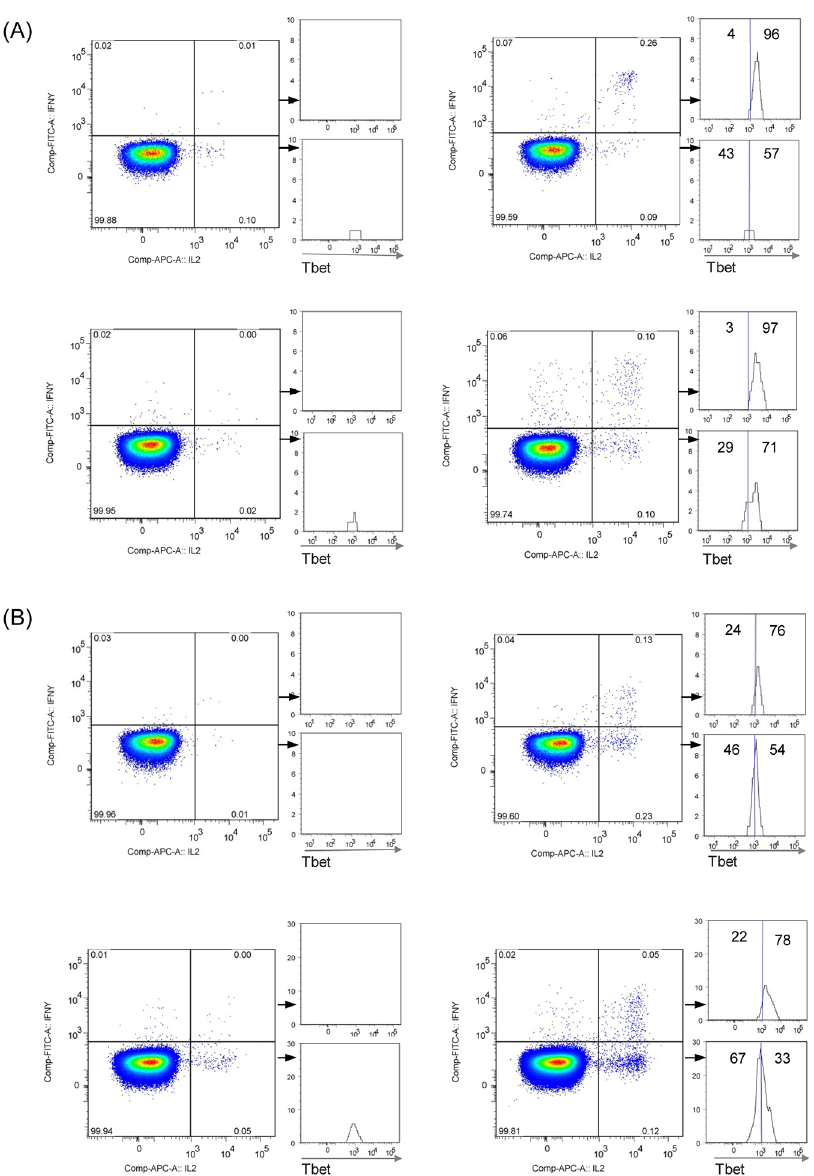
Fig 3. Reduced Th1 lineage transcription factor Tbet expression in TBEV-specific IL-2 + IFN- γ - CD4 + T cells. Human PBMC from 2 TBE patients (A) and 2 TBE vaccinated persons (B) were stimulated with TBEV E peptide pools (right panel) or no antigen (left panel). Plots were gated on lymphocytes, live cells, singlets, CD3 + CD4 + , CD4 + CD45RO + . Histograms show expression of Tbet in IL-2 + IFN- γ - (lower quadrants) or IL- 2 + IFN- γ + populations (upper